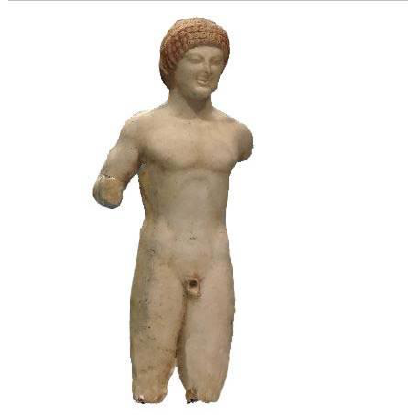
Figure 4. 3D Model Dressel